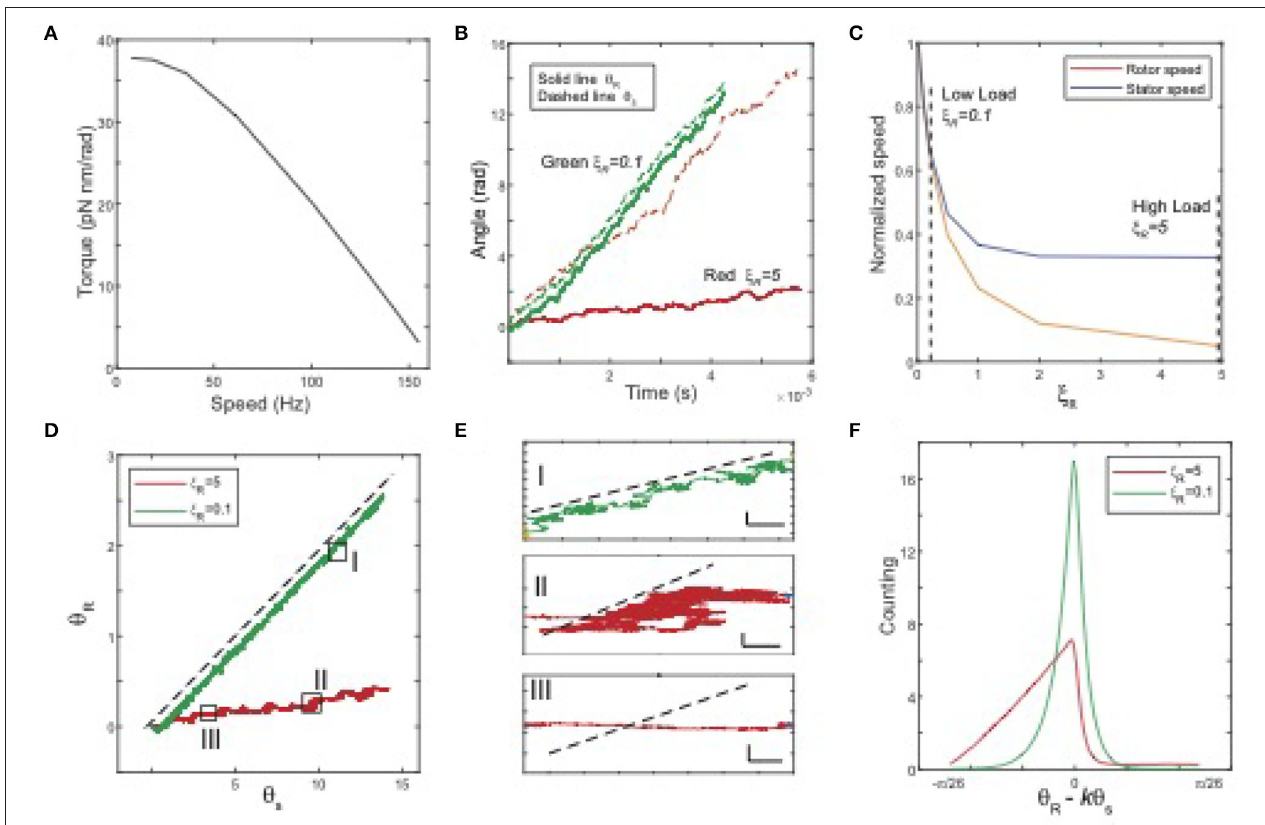
FIGURE 2 | Model results. (A) The torque-speed curve from the model with simple choices of the interaction potentials ( V R and V S ) and the transition (stepping) rate k m (parameters are given at the end of the caption). (B) Time series of θ R (solid line) and θ S (dashed line) for different rotor loads. Red: high load ξ R = 5, green: low load ξ R = 0.1. (C) The normalized average speeds of the rotor (yellow) and stator (blue) vs. the rotor load ξ R . (D) Trajectories in ( θ R , θ S ) space for different loads. Dashed black line: θ R = k θ S , with k = 1θ R /1θ S = 5 / 26. The three boxes highlight the three different types of motions. (E) Three typical movements with zoom-in trajectories [highlighted in (D) ]. I: rotor moves along with stator without slipping; II: reduced net speed for both rotor and stator; III: stator rotates while rotor speed is near zero. The black dashed lines indicate the no-slip motion θ R = k θ S . Horizontal scale bar: 0.3 rad; vertical scale bar: 0.1 rad. (F) The distributions (histogram) of ϕ = θ R − k θ S for a high load and a low load. Parameters and simulation methods are given in the Supplementary Materials .